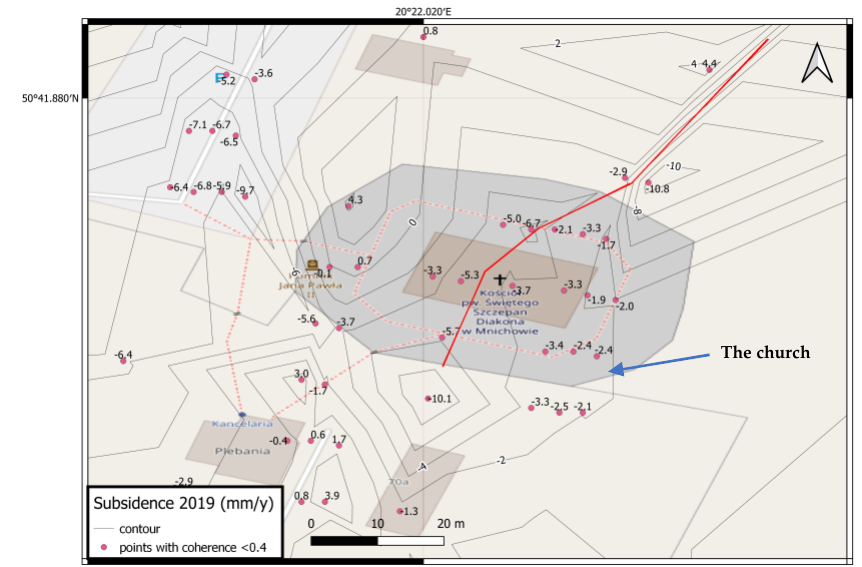
Figure 16. Annual ground depressions (grey contour lines and red points) near the church observed in the period January—December 2019, corresponding to the date of geodetic measurements. Red line—observed division on two regions crossing the church building.